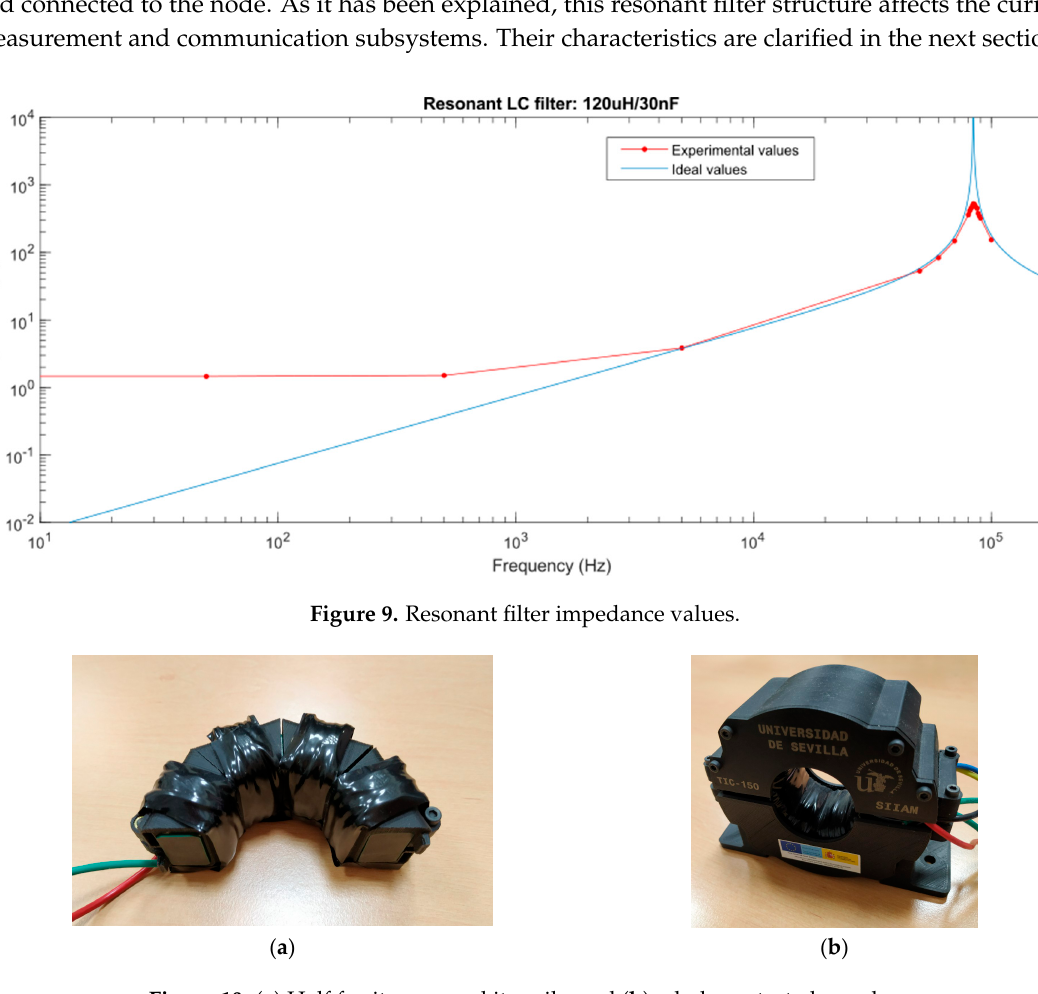
(2) Figure 8. Communication-measurement connection. Finally, the impedance value is equal to: |𝑍(cid:4666)𝜔(cid:4667)| (cid:3404)